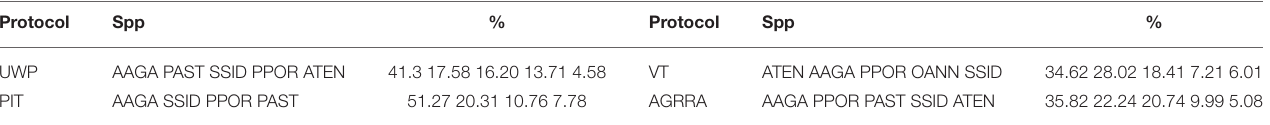
TABLE 3 | Dominant species in terms of cover, identified with a SIMPER analysis by each sampling design, the order of appearance indicates the contribution to the total cover. Protocol